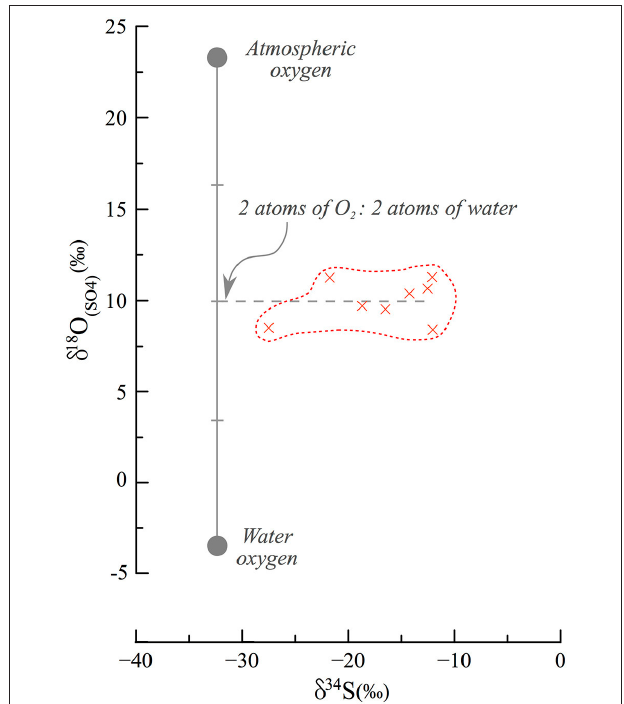
FIGURE 8 | End member mixing and oxidation pathways in secondary gypsum. Assuming that atmospheric oxygen (23 h ) and local meteoric water ( − 6 to − 3 h ) are the source of oxygen to the oxidation process of sulfides, they each contribute an equal fraction of oxygen atoms. Previous studies have typically discussed the contribution of one O 2 atom from atmospheric oxygen and 3 atoms from water, and this is the first such observation of an implied equal